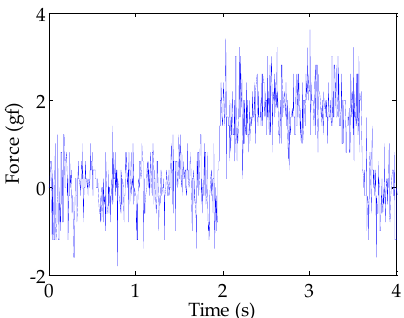
Figure 9. The z-axis calibrated sensor measurements (S z,c ) when a weight of 1 g (contact area of about 1 cm 2 ) is placed on the sensor at a time of around 2 s. The calibration is slightly incorrect in this case, showing a measurement of 2 gf. This might be partially due to the different contact area than that during the calibration. Nevertheless, it can be seen that the sensor can already detect a 1 g weight. Table 1. R-squared value for the normal force and shear force experiments.